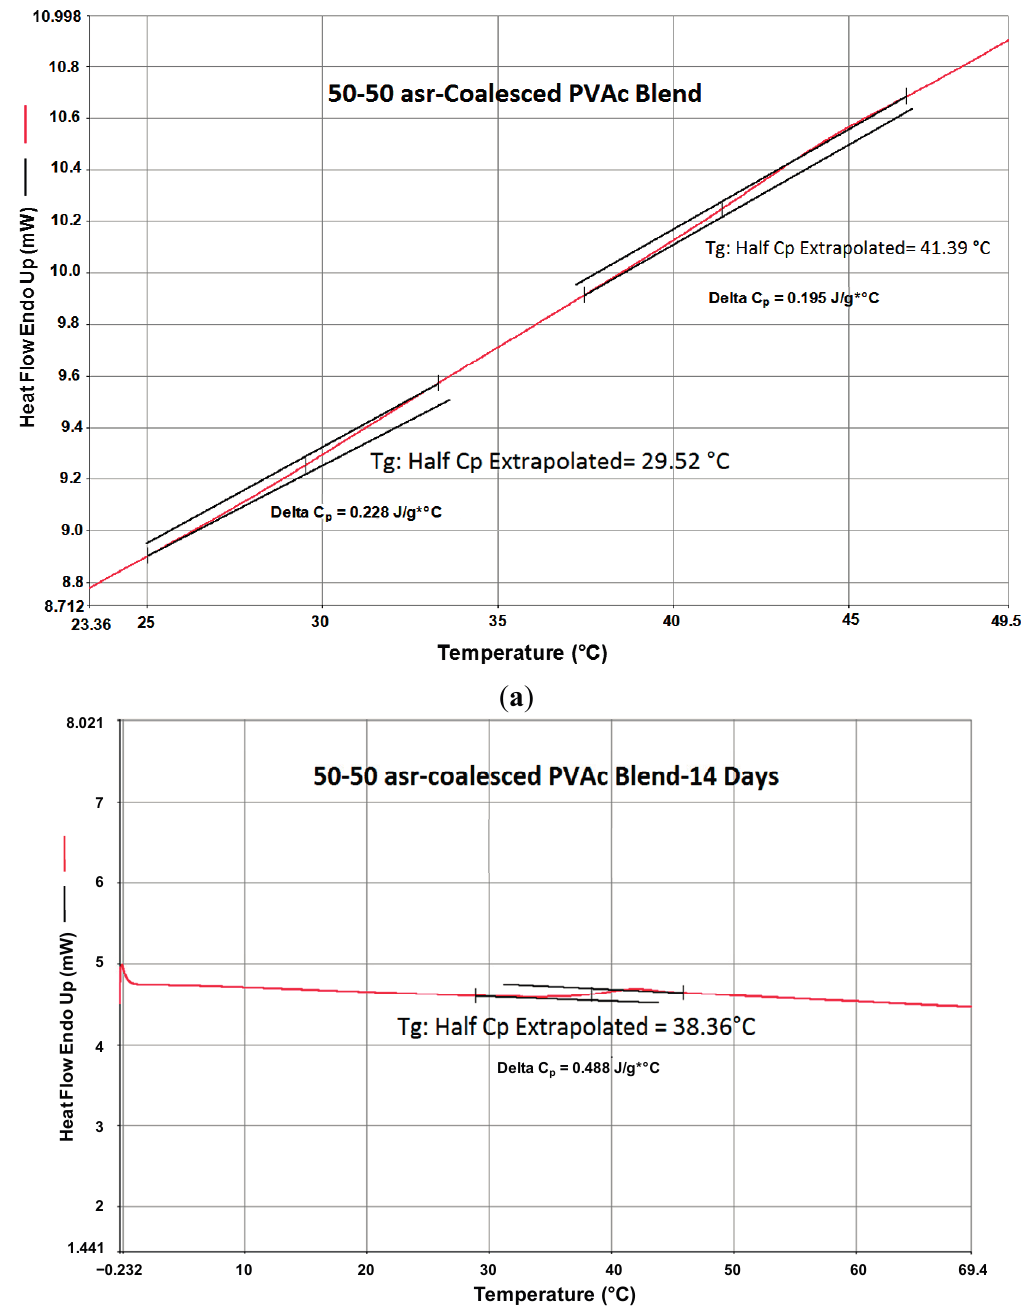
Figure 9. DSC scans of an initial 50/50 physical mixture of asr-PVAc/c-PVAc ( a ) before and ( b ) after annealing for 14 days at 70 °C